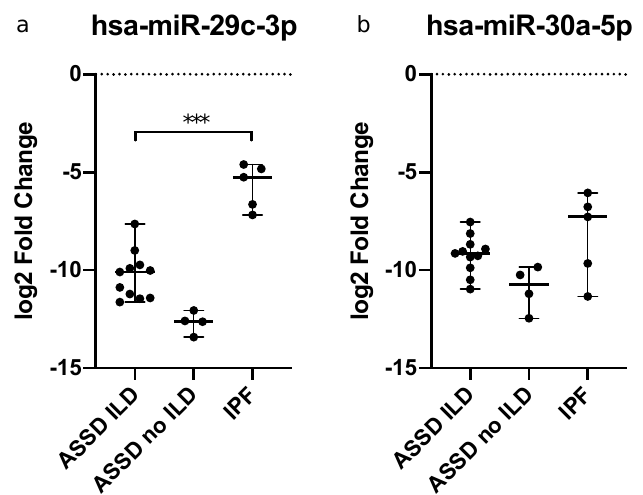
Figure 3. Quantitative expression of ( a ) hsa-miR-29c-3p, and ( b ) hsa-miR-30a-5p in the plasma-derived exosomes of ASSD patients (with and without ILD) and IPF patients. Log2 transformed values. *** p < 0·001.